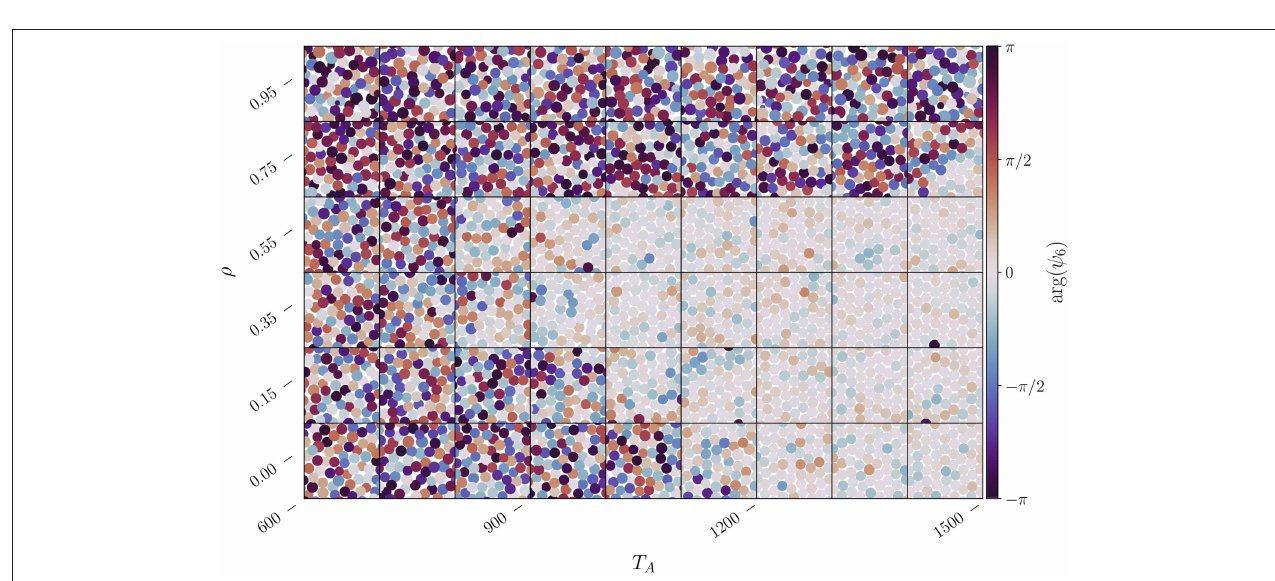
FIGURE 3 | The pair correlation function g ( r ) for a system with L Within each panel, the g ( r ) function has been shifted upwards from zero for visualization purposes. For the case ρ and as such the T A values are not precisely the same as the one used for the cases when ρ differences do not take away from the qualitative differences presented here.